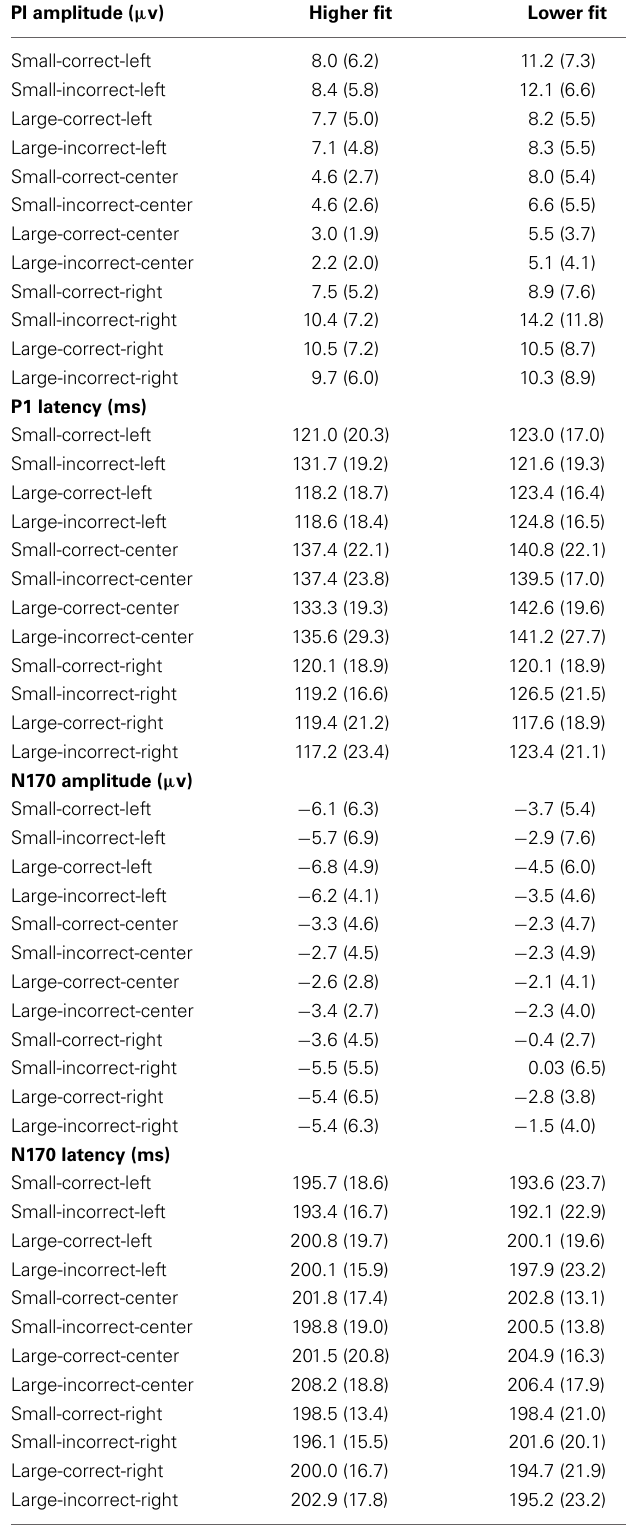
Table 2 | Amplitude and latency data for the N170 and PI components for higher fit and lower fit